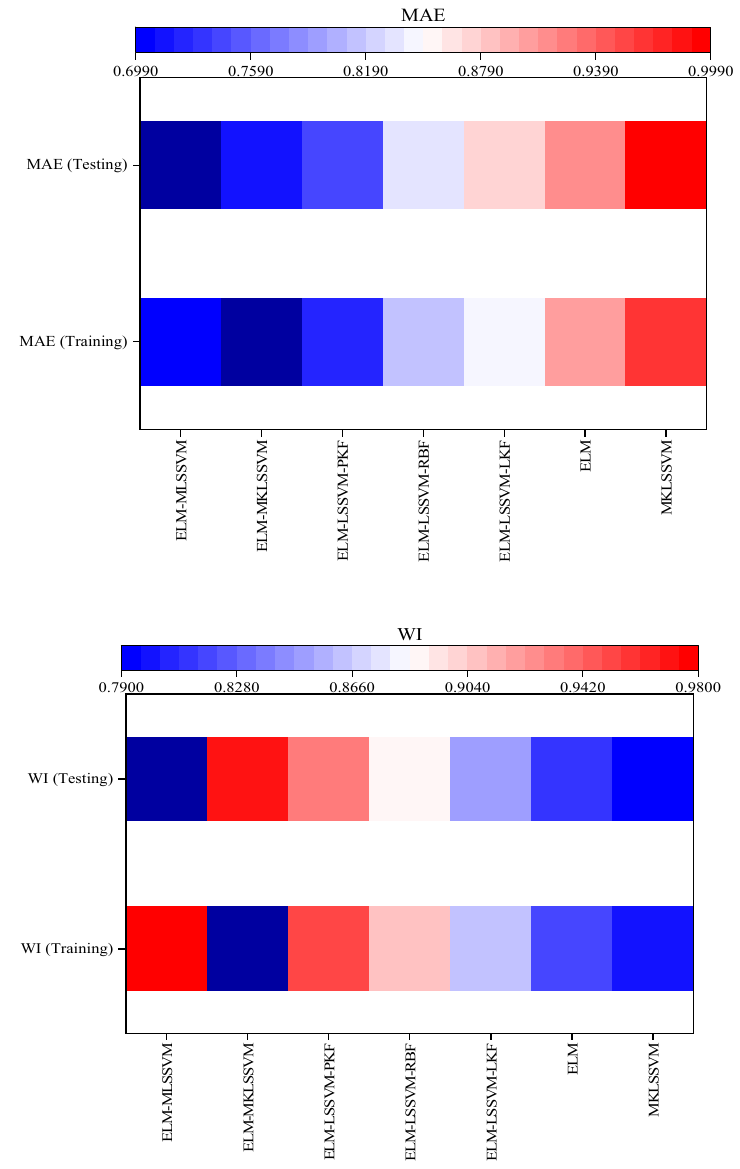
Figure 4. Heat maps of error values. The highest NSE was obtained by the ELM-MKLSSVM model. The training and testing NSEs of the ELM-MKLSSVM model were 0.98 and 0.97, respectively. Therefore, the NSE of the ELM was higher than that of the MKLSSVM model. The training and testing NSEs of the ELM-RBF model were higher than those of the ELM-LLSVM-PKF model. The training and testing NSEs of the ELM-RBF model were 0.92 and 0.90, respectively. The WI of the ELM-MKLSSVM model was 0.98 and 0.97 at the training and testing level. The WI of the ELM-MKLSSVM model was higher than that of the other models. The WI values indicated that the ELM-LSSVM-PKF was the second-best model. The training and testing WIs of the same model were 0.95 and 0.93. The NSE of the same model was lower than that of the ELM-MKLSSVM model. The MAE of the ELM was higher than that of the ELM-MKLSSVM models. The training and testing MAEs of the ELM model were 0.901 and 0.912, respectively. The training and testing MAEs of the MKLSSV model were 0.70 and 0.71, respectively. The testing MAE of the ELM-MKLSSVM model was 28% lower than that of the MKLSSVM model.